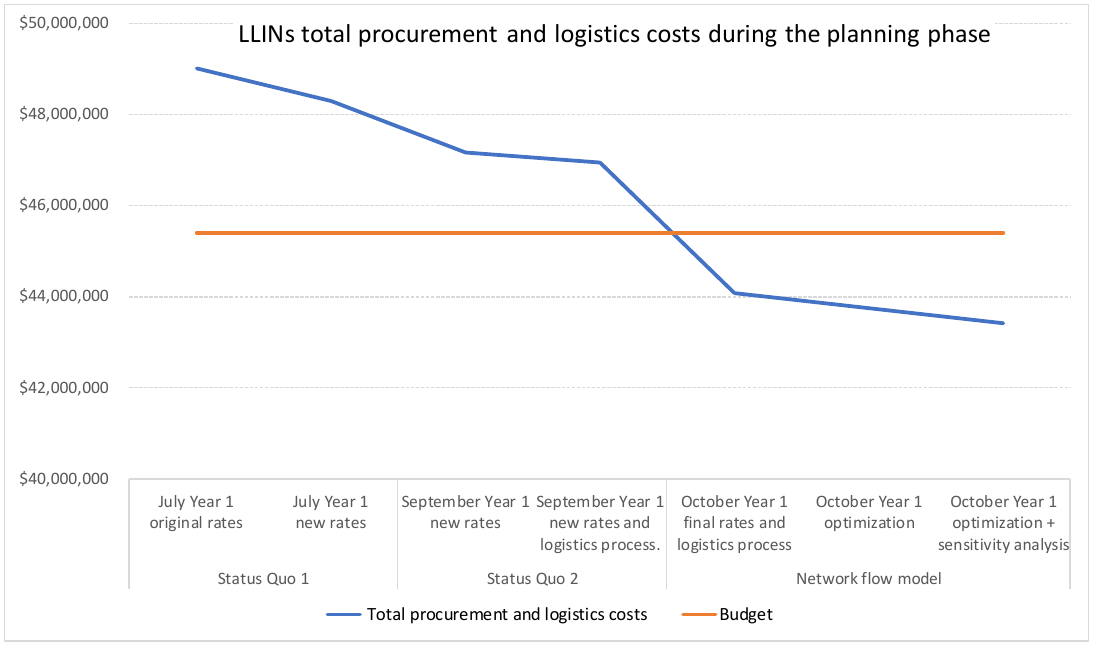
Figure 5. Visual representation of the LLINs total procurement and logistics cost during the planning exercise and the budget.